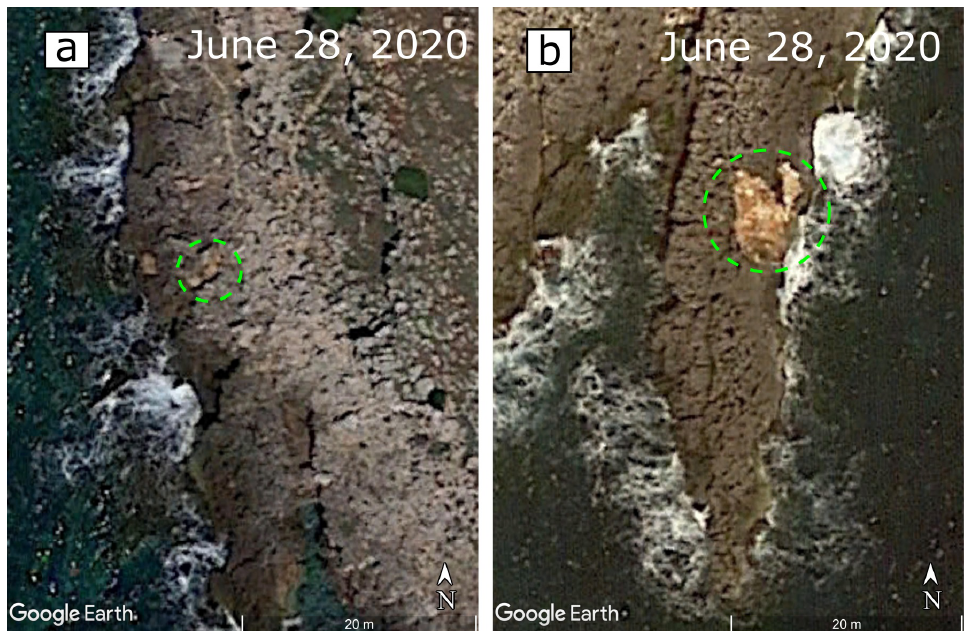
Figure A8. Satellite images of sockets: ( a ) The June 2020 image of the sockets of the boulders CIa,b,c,d (eye elevation of 35 m). ( b ) The June 2020 image of the sockets of the boulders SEa,b (eye elevation of 35 m).